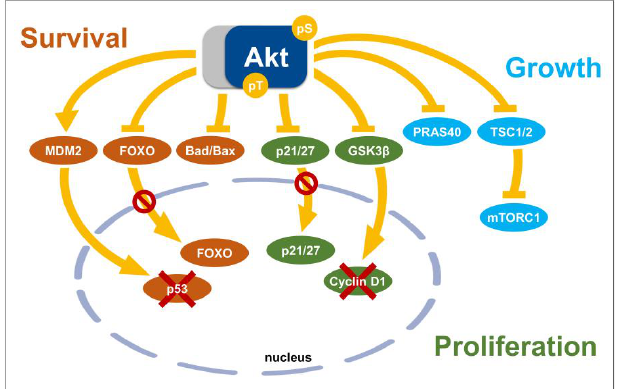
Figure 2. Schematic representation of Akt-substrates involved in the regulation of the cellular radiation response. Akt mediates several subcellular processes, e.g., survival, growth and phosphorylation by phosphorylating different target proteins. Phosphorylation of different Akt targets involved in survival (orange), proliferation (green) and growth (blue) leads to an activation or inhibition of their function. Arrows depict activating phosphorylation whereas blocking lines depict inhibitory phosphorylation. Nuclear translocation of p21/27 and FOXO3A is inhibited upon phosphorylation by Akt depicted by red cross.